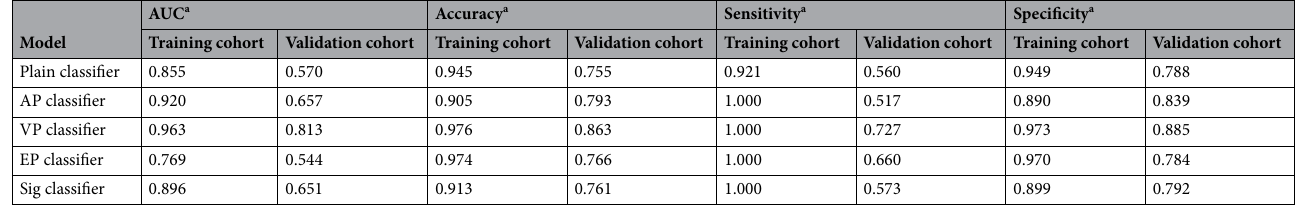
Table 2. Diagnostic performance of each classifier in training and validation cohorts. AP arterial phase, VP portal venous phase, EP equilibrium phase. a AUC mean area under the curve.